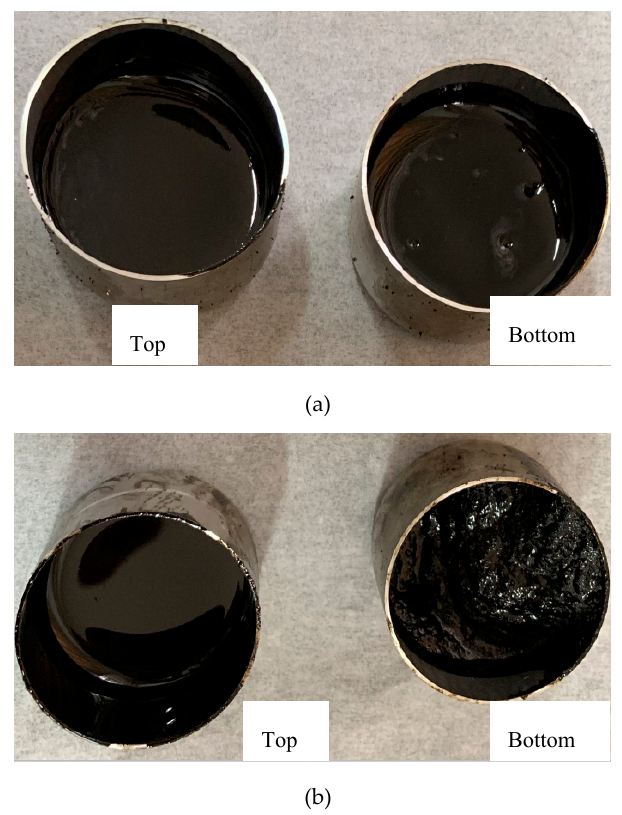
Figure 7. A-G-R ( a ); and CRMA ( b ) stored for 48 h at 163 ◦ C. Materials 2019 , 12 , x FOR PEER REVIEW